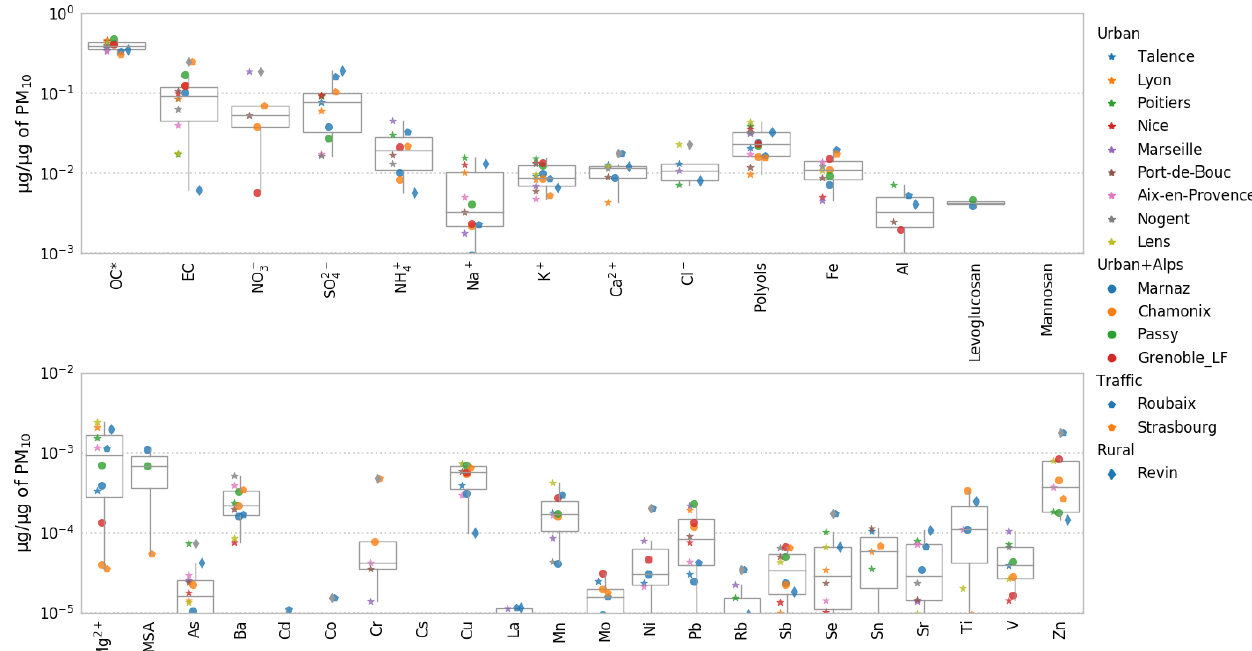
Figure 10. PMF chemical profile of the PBOA factor in the DECOMBIO and SOURCES programs expressed as a fraction of the PM mass. Values lower than a few pgµg − 1 are not displayed on purpose. For each box, the top, middle, and bottom lines represent the 75th, median, and 25th percentile, respectively. The whiskers at the top and bottom of the box extend from the maximum to the minimum. OC ∗ corresponds to the bulk organic carbon fraction minus the carbon in the characterized organic species. MSA is methanesulfonic acid.